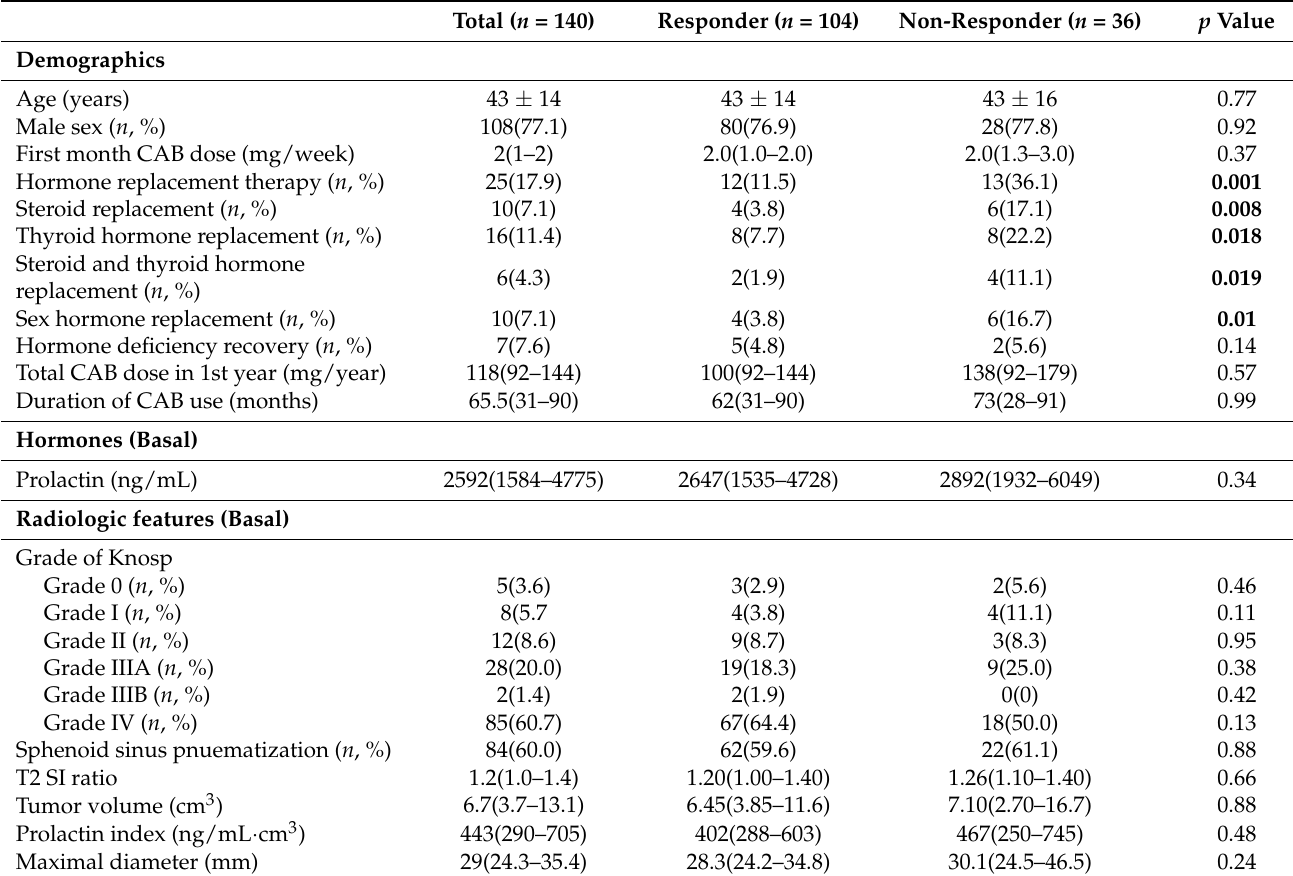
Table 1. Baseline characteristics and radiologic characteristics of bioactive prolactinoma according to hormonal and radiologic response of